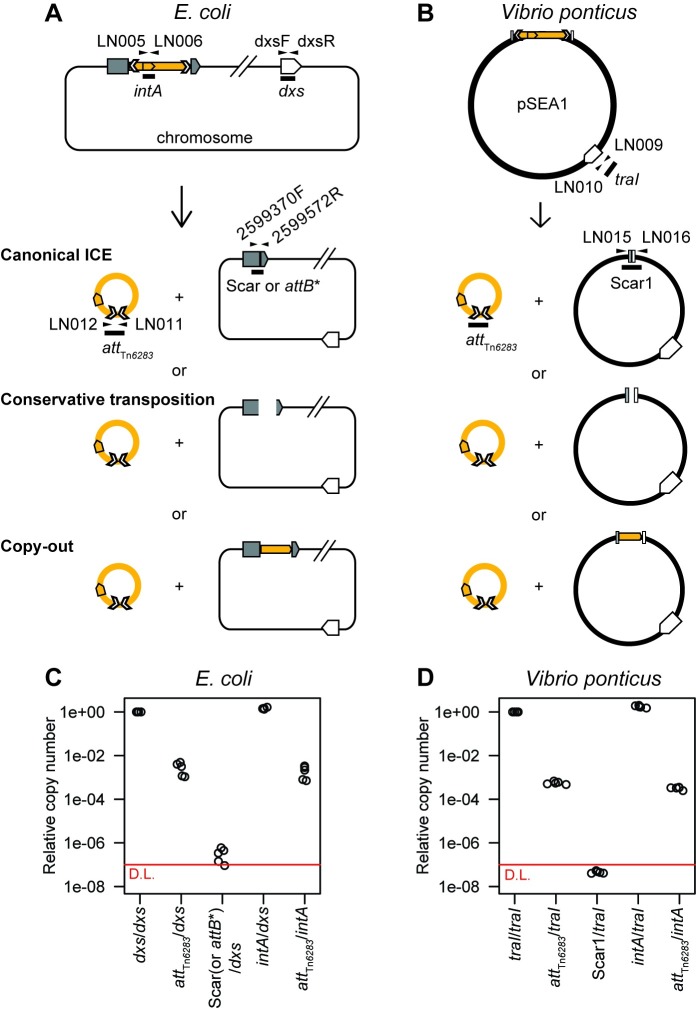
Tn6283 excision barely generates unoccupied donor sites in vivo.(A) A model for Tn6283 excision in E. coli strain LN5. Three models are proposed (see main text for details). Primer sets used for qPCR are indicated as arrows. (B). A model for Tn6283 excision in V. ponticus. (C) Copy numbers of recombination joints in E. coli. Copy numbers of two recombination joints (attTn6283, attB*) shown as the ratio of the number of joints to the number of replicon backbone (dxs) or total Tn6283 molecule (intA). In one sample, the copy number of attB* was below the detection limit. (D) Copy numbers of recombination joints in V. ponticus. Copy numbers of two recombination joints (attTn6283, Scar1) shown as the ratio of the number of joints to the number of pSEA1 backbone (traI) or total Tn6283 molecules (intA). Each dot indicates total DNA extracted from one batch of stationary-phase cultures. The amount of Scar1 was too low to detect in a quantitative manner (outside the range of standard curve), and is thus shown as the numbers below the detection limit (red line: 10−7).